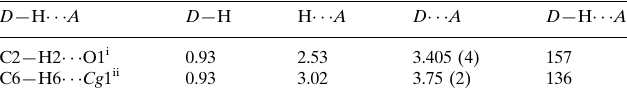
Hydrogen-bond geometry (A˚ , (cid:1) ). Cg 1 is the mid-point of atoms C15 and